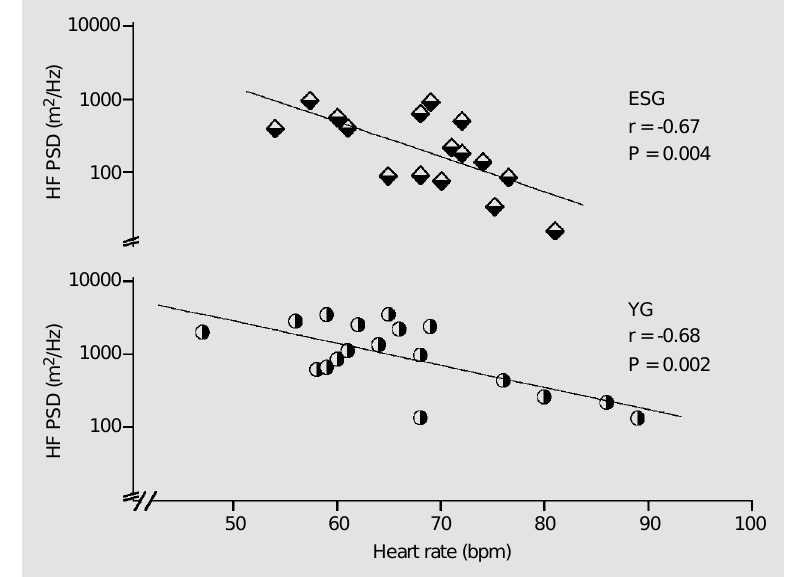
Figure 2 - Fitted regression line of natural log transformation of the power spectrum density (PSD) of the HF band (in ms 2 /Hz) as a function of resting heart rate (bpm) for ESG (N = 16) and YG (N = 18). For abbreviations, see legend to Table